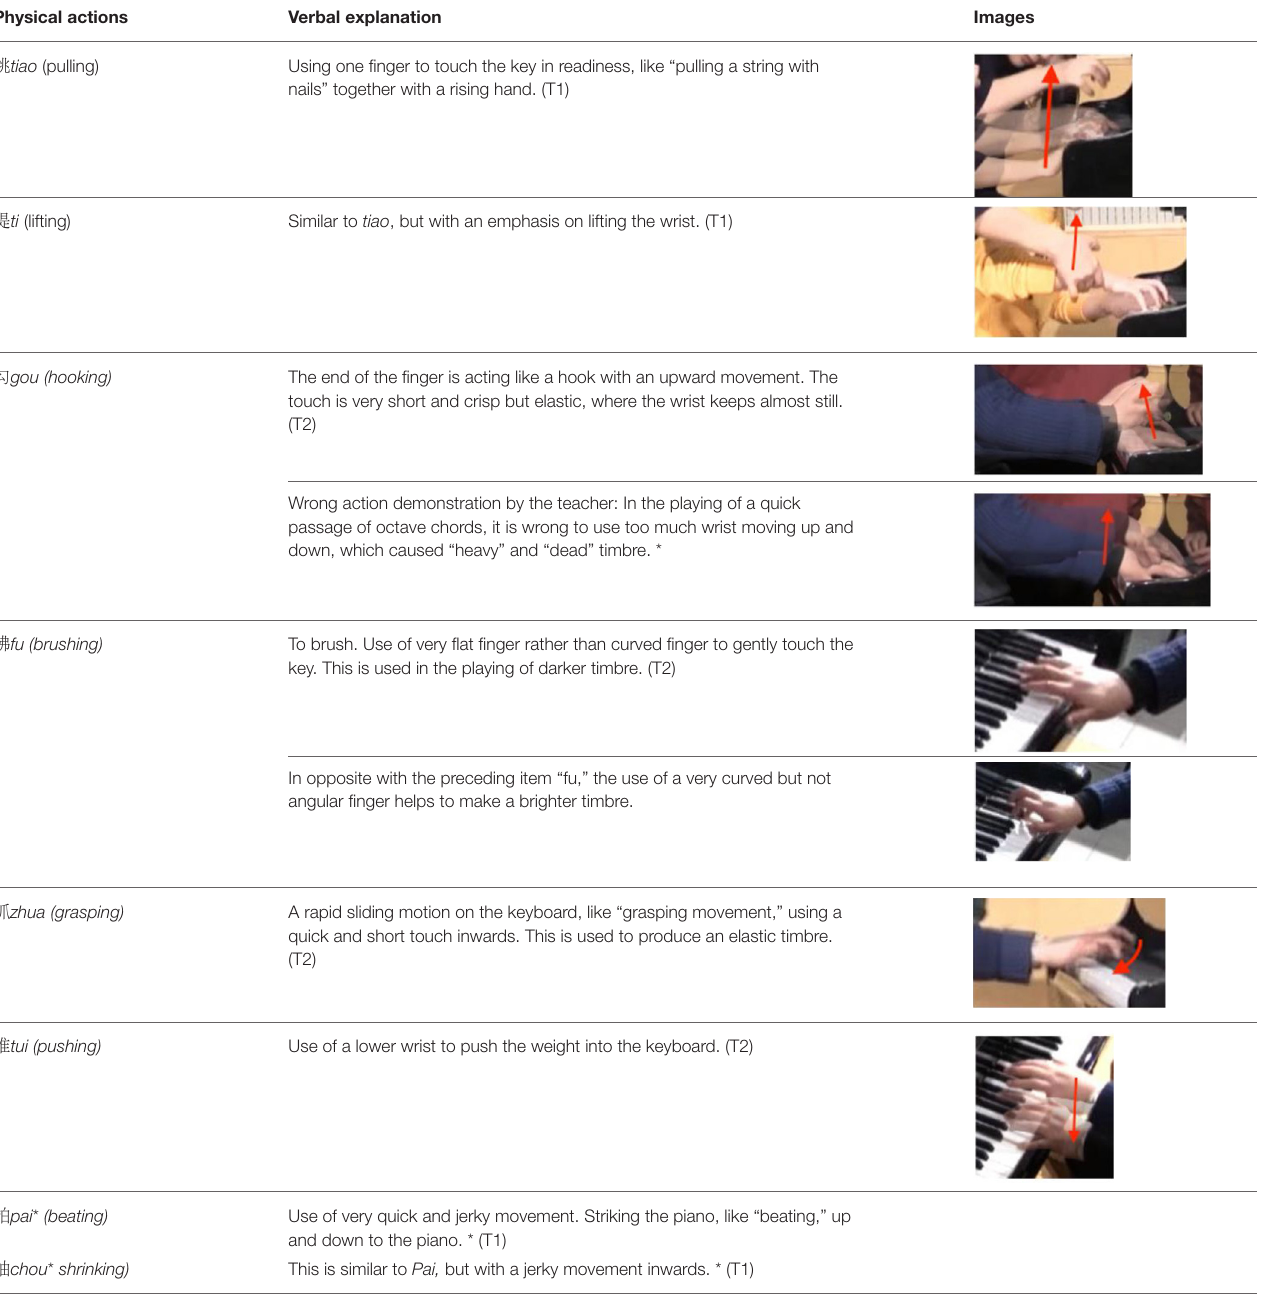
TABLE 4 | Examples of physical actions and the corresponding explanation in words and movement. Physical actions Verbal explanation